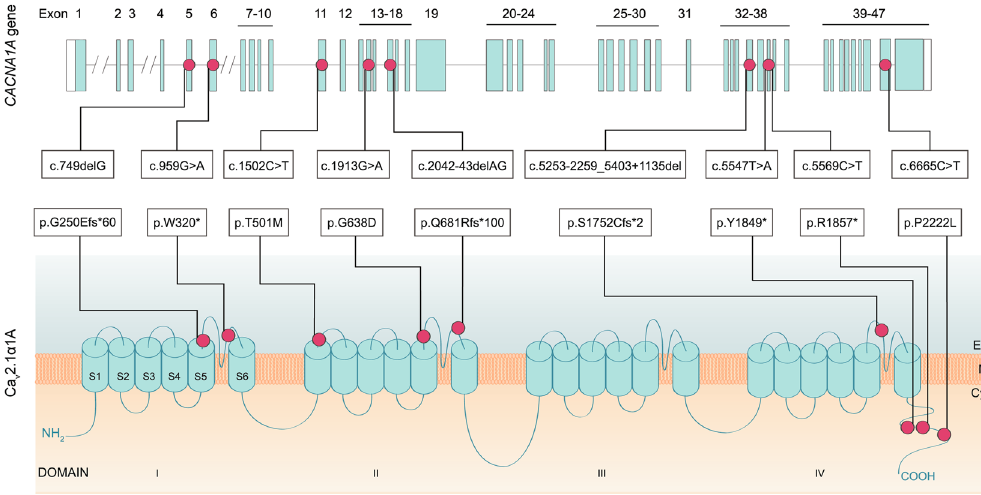
Figure 1. CACNA1A gene and protein structure with the identified pathogenic variants. CACNA1A gene structure (top figure), with boxes indicating exons. Protein structure of the Ca v 2.1 α 1A subunit (bottom figure). The genetic variants reported in this work are indicated by dots. Cyt: cytoplasm; M: cytoplasmic membrane; ES: extracellular space; S: Segment. Reference sequence for cDNA nomenclature: NM_001127221 (nucleotide c.279A corresponding to the initiation codon, ATG). Rererence sequence for protein nomenclature: